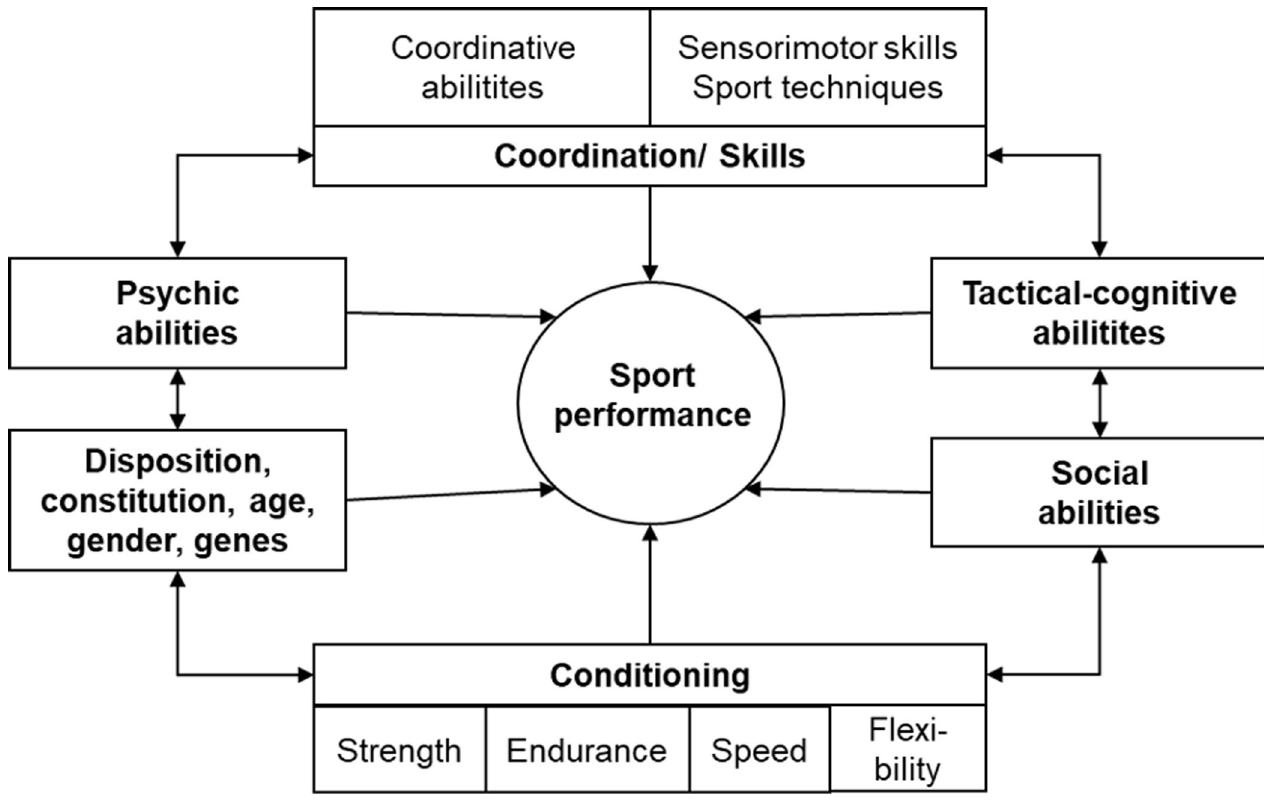
Fig 2. Generic model of sport performance [15].